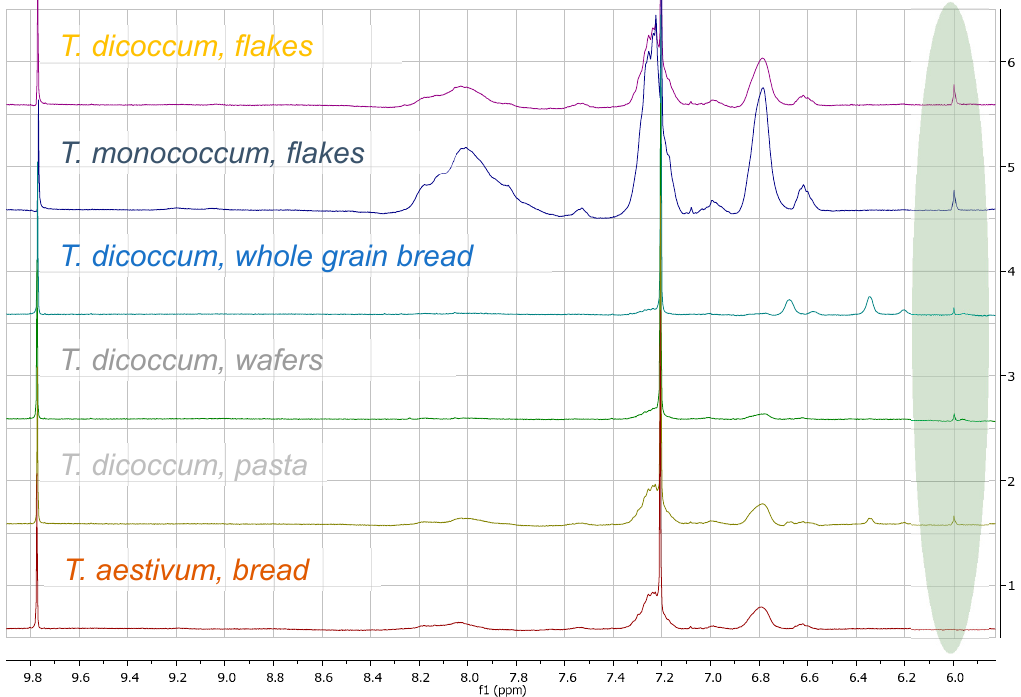
Figure A8 . 1 H-NMR spectra in d 6 -DMSO of extracts of wheat products showing the ARS peak.